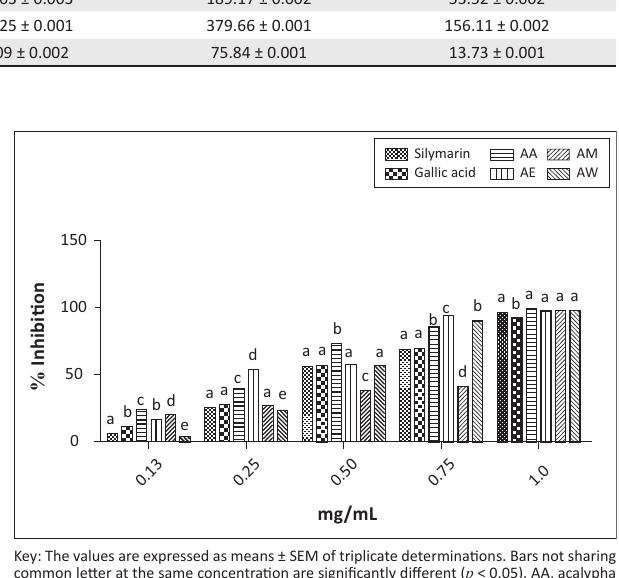
TABLE 2: Total phenolic composition of extracts of Acalypha godseffiana (leaves). Phytochemicals